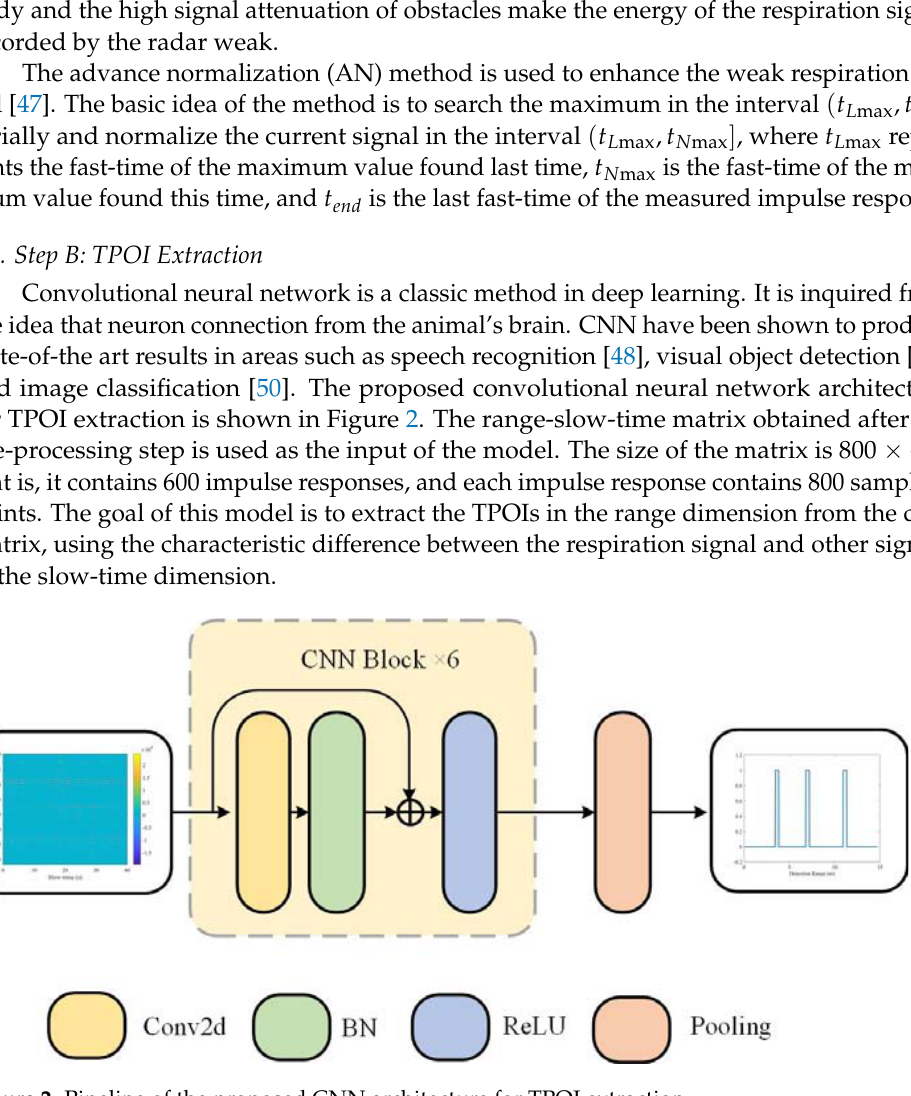
Figure 2. Pipeline of the proposed CNN architecture for TPOI extraction.